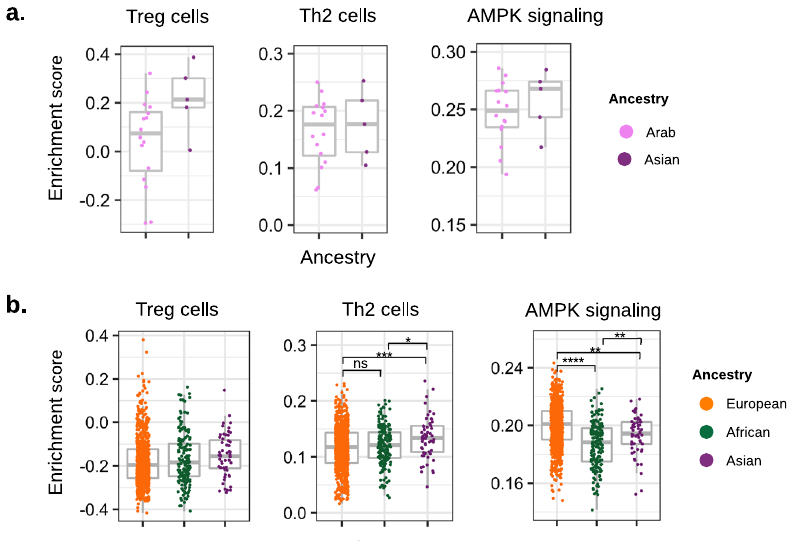
Fig. 5 Enrichment of selected immune cell subpopulations and oncogenic pathways in Arab breast cancer patients. Enrichment scores for signatures for T-regulatory cells (Tregs, left), T-helper 2 cells (Th2, middle), and AMPK signaling (right) in panel ( a ). RA-QA cohort comparing ArA to AsA breast cancer patients, independent of molecular subtype. b TCGA breast cancer cohort comparing EA, AA and AsA breast cancer patients, independent of intrinsic molecular subtype. Box plots indicate medians and interquartile range, and whiskers represent 10th and 90th percentile. All data points are plotted individually. T test (two-sided): * p < 0.05, ** p < 0.01, *** p < 0.001, **** p < 0.0001, and ns, not signi fi